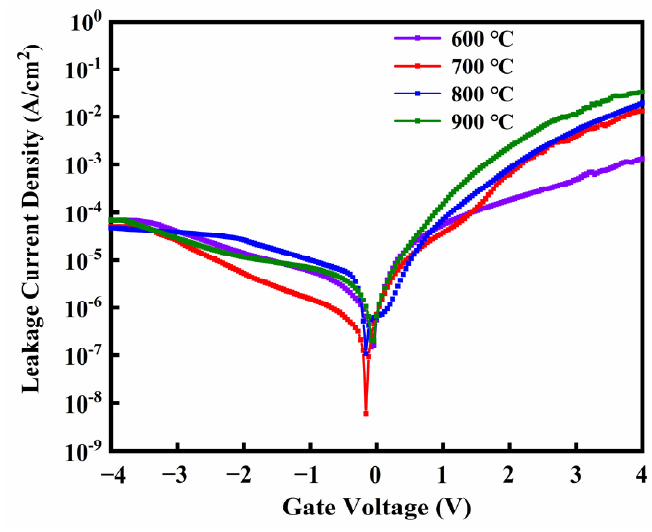
Figure 12. Leakage current density–voltage (J-V) characteristics of AZO dielectric films. Table 2. The related electrical parameters of some dielectric materials are reported in the literature and in this